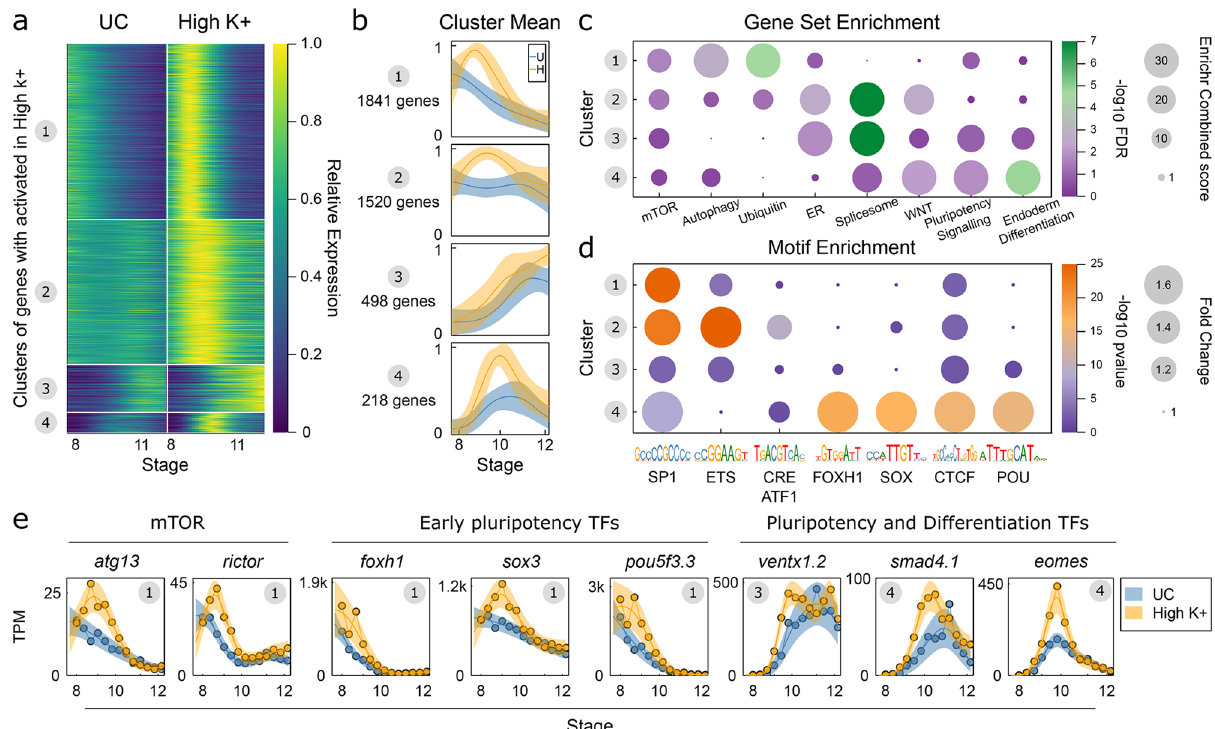
Fig. 6 | High-resolution temporal RNA-seq identi fi es mTOR and Ca 2+ Gene Regulatory Network. a , b Summary of activated gene clusters by a heatmap and b cluster average. Data is Gaussian process median for each gene normalized by maximal value, shaded region in b is ±1SD for each cluster. UC untreated control; High K + (=depolarizing conditions). c Bubble plot for selection of gene set enrich- ment terms, calculated with Enrichr, see Methods for de fi nition of terms, and Supplementary Data 1 for full set of enrichments. Bubble size re fl ects Enrichr Combined score and color indicates − log10 FDR. d Bubble plot enrichment of TF